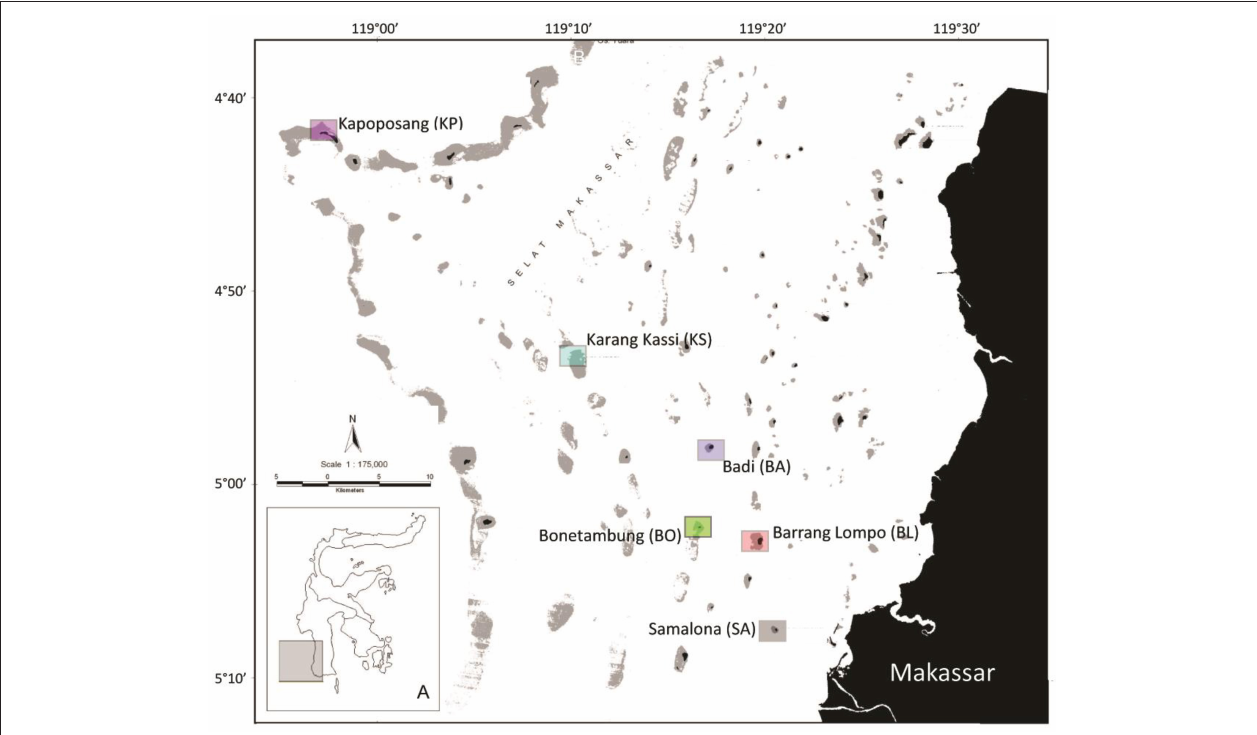
FIGURE 1 | Map of the Spermonde Archipelago with inset (A) indicating the islands’ location in reference to Sulawesi, Indonesia. Squares indicate the sampling sites and the in-text acronym is given in parentheses. Colors correspond with Figures 5, 6